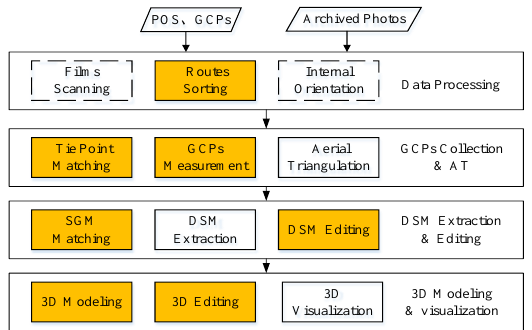
Figure 1. Work flow of 3D scene modelling with archived non-oblique aerial photos